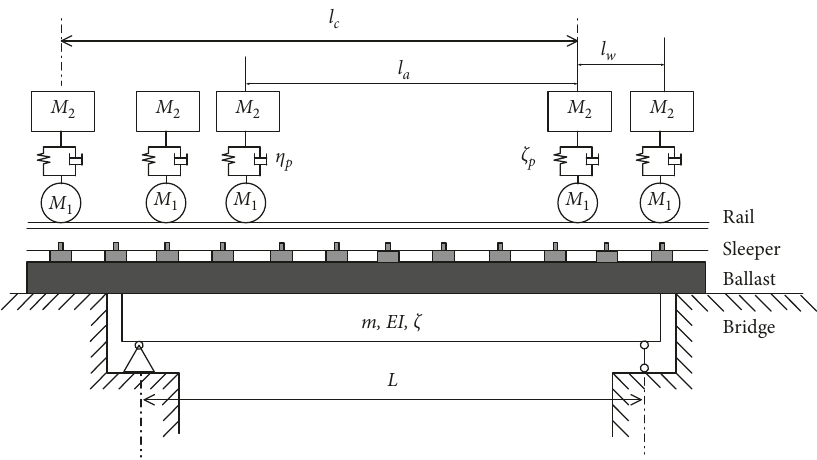
Figure 13: Configuration of the vehicle-bridge dynamic interaction system. Table 2: Mechanical characteristics of the high-speed